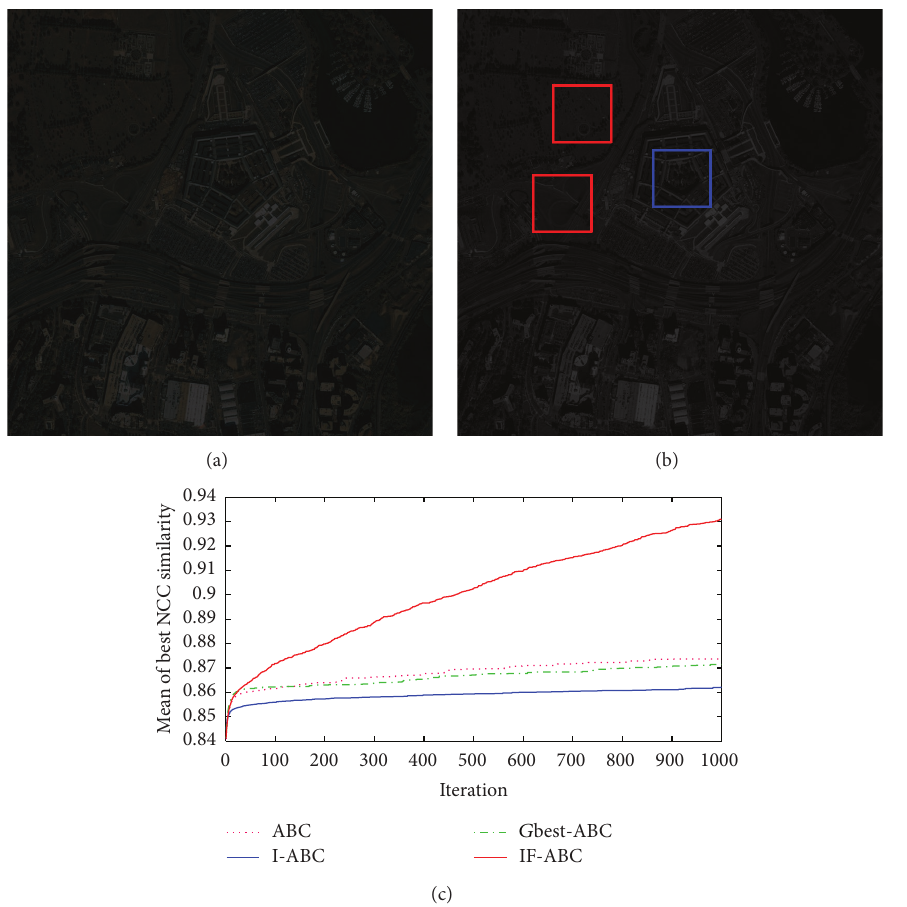
Figure 11: Practical template matching case 4. (a) Underexposed source image; (b) ground matching truth (blue box) and most common false matching results (red boxes); (c) comparative evolution curves of four ABC